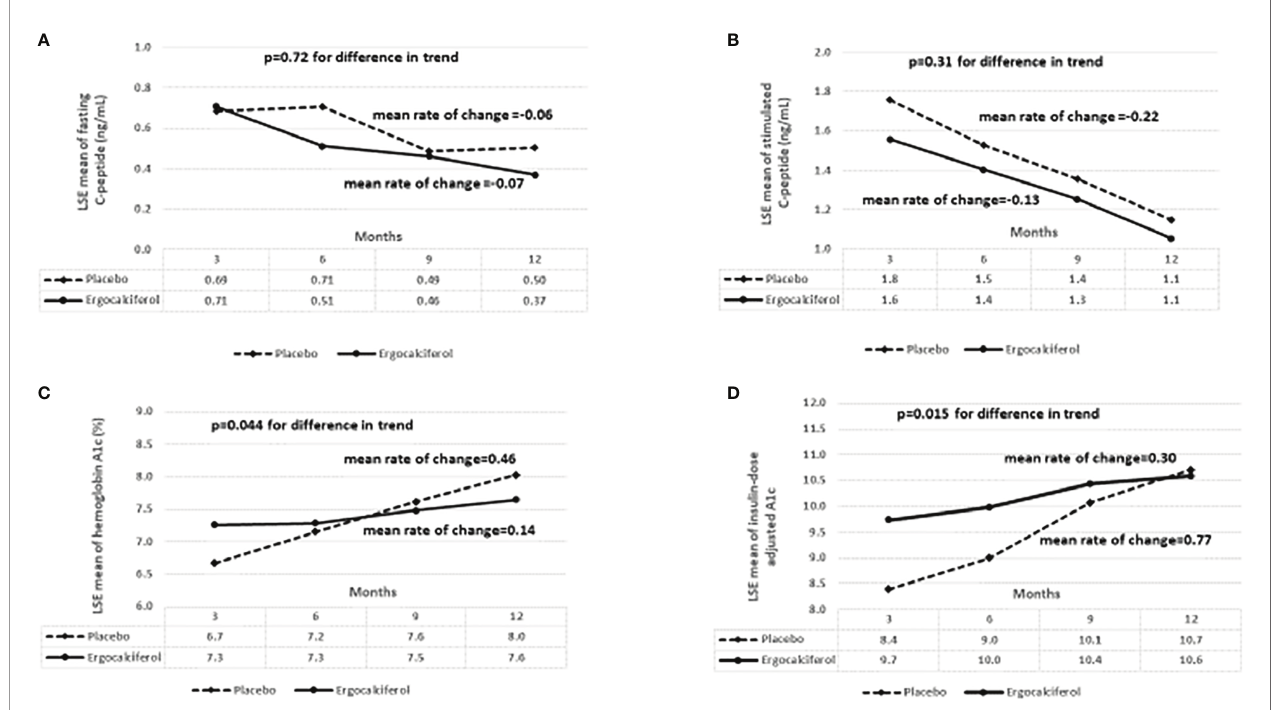
FIGURE 2 | (A) shows the trend analysis of the least square estimates (LSE) of the means for fasting C-peptide. There was no signi fi cant difference in fasting C-peptide concentration between the ergocalciferol and placebo groups during the 12-month trial, (p=0.72). (B) There was no signi fi cant difference in the change in stimulated C-peptide concentration at 90 minutes between the ergocalciferol- and placebo-treated patients with type 1 diabetes during the 12-month trial, (p=0.31). (C) Temporal trend analysis showed a faster rate of rise in hemoglobin A1c (HbA1c) values in the placebo group compared to the vitamin group (p=0.044). (D) Temporal trend analysis showed a signi fi cantly faster rise in insulin dose adjusted A1c (IDAA1c) in the placebo group compared to the ergocalciferol group (p=0.015). This suggests beta-cell protection by